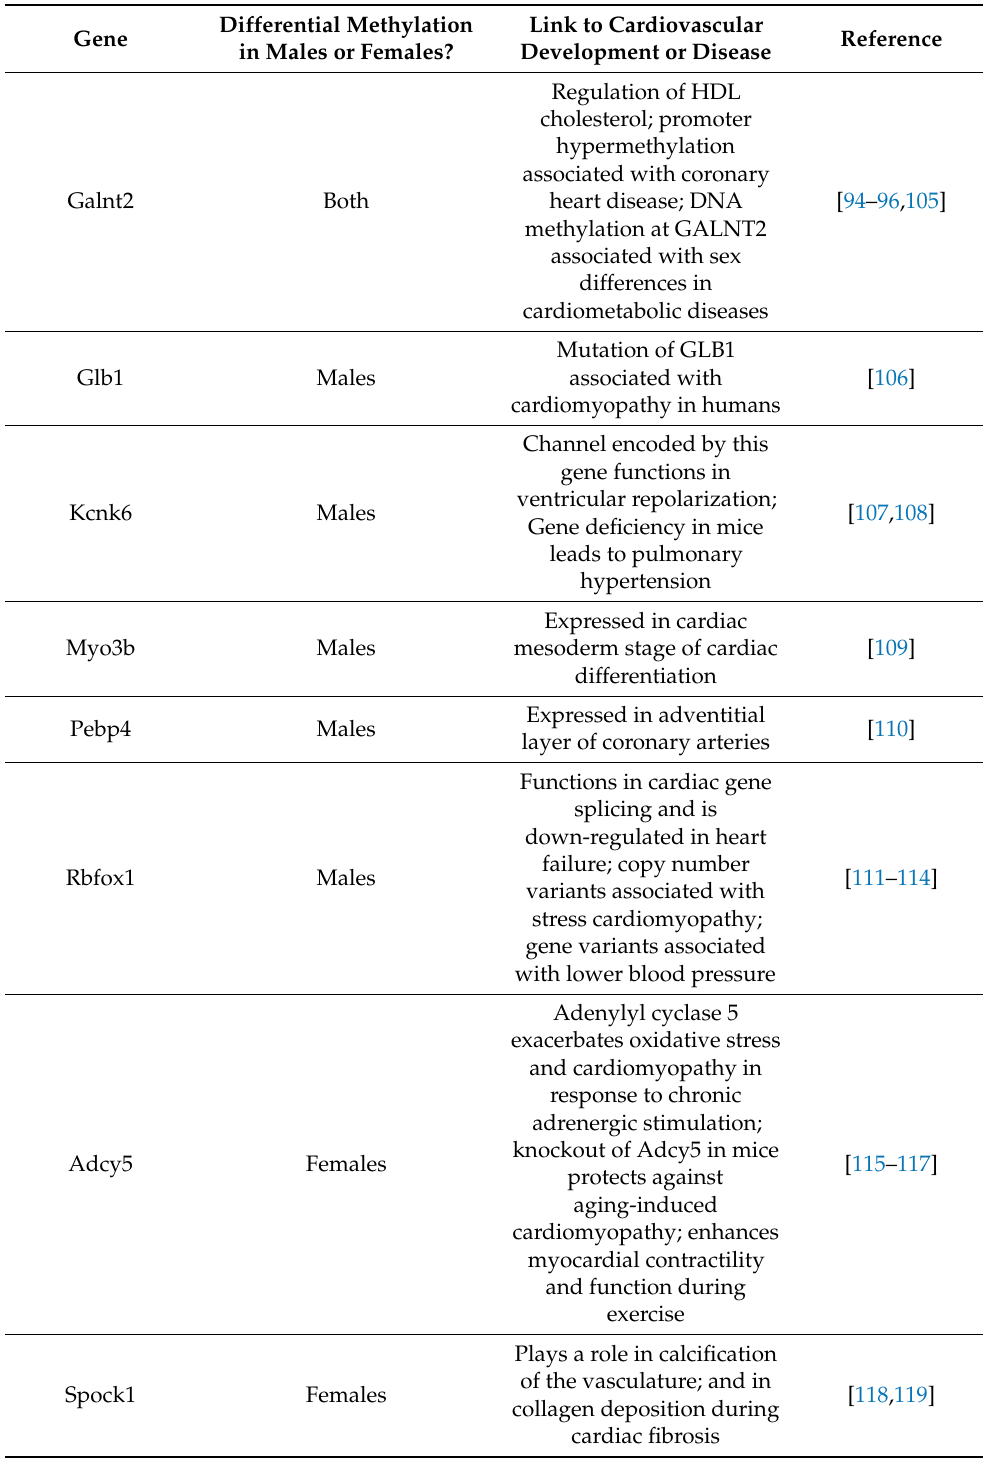
Table 5. Literature summary of DMR-associated genes at weaning that also show differential methy- lation in mice at 5 months of